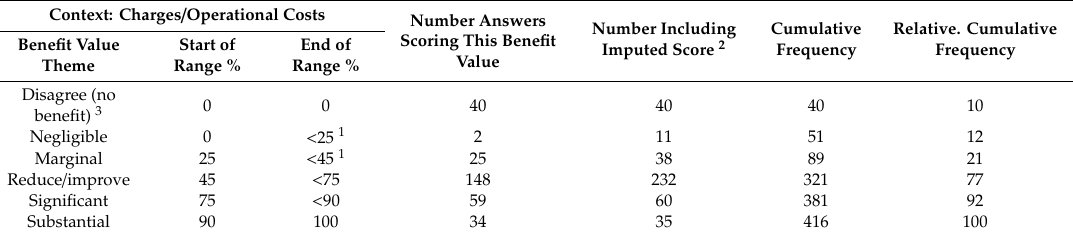
Table 9. Qualitative-to-quantitative transformation of benefit value—charges / operational costs.